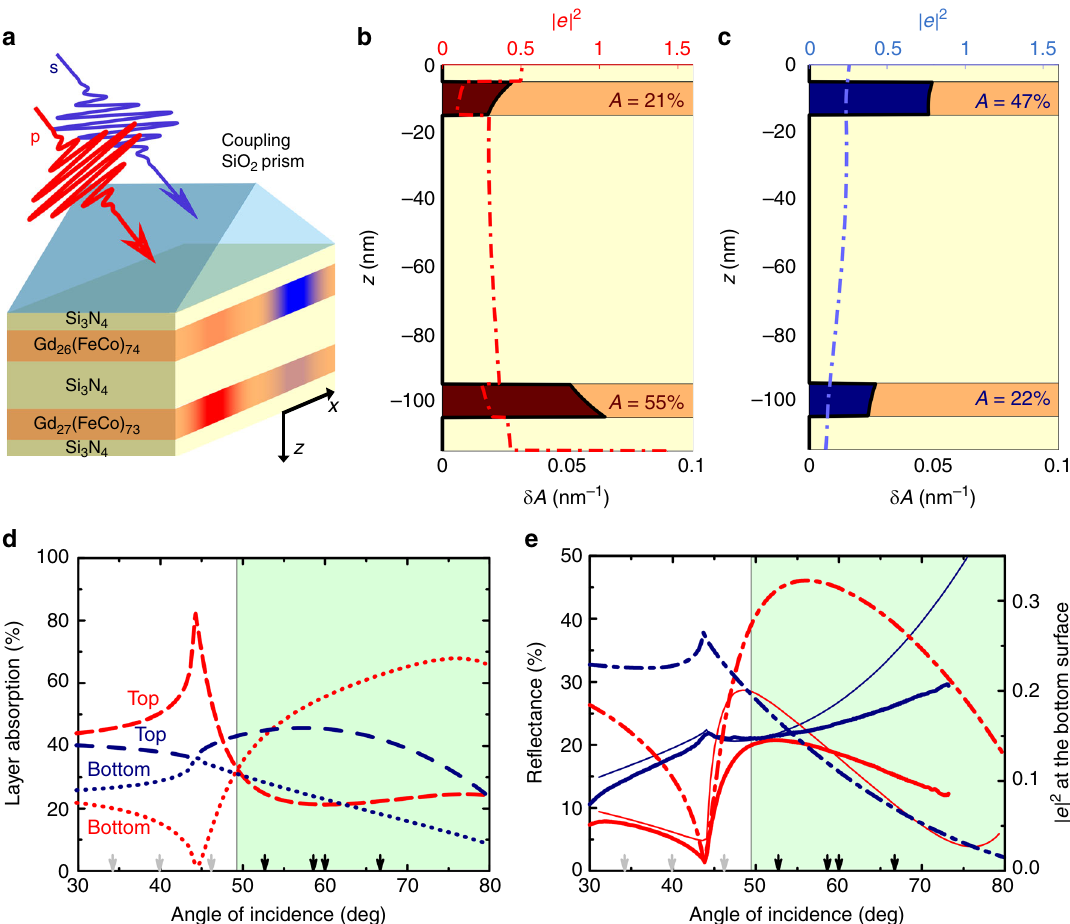
Fig. 1 The scheme of polarization-based layer-resolved all-optical toggling of magnetization. a Physical scheme and sample design. The p-polarized/s- polarized optical pulse (and the associated targeted layer for magnetization reversal) is shown by red/blue. b , c The distribution of | e | 2 (dashed-dotted line) and the partial δ A and total A absorption (solid line) inside the multi-layered heterostructure for p-polarized and s-polarized optical pulses respectively, with fi xed wavelength 800 nm and angle of incidence 59°. d Calculated angular dependence of the absorbed optical energy by the top (dashed line)/ bottom (dotted line) layer with incident p-polarized (red)/s-polarized (blue) light. e Calculated (thin solid lines) and experimentally measured (thick solid lines) re fl ectance angular spectra for incident p-polarized (red)/s-polarized (blue) light. Also shown is the calculated strength of | e | 2 at the bottom surface of the bottom Gd 27 (FeCo) 73 layer with incident p-polarized (red dashed-dotted line)/s-polarized (blue dashed-dotted line) light. In panels d-e, the green background colour indicates the predicted region where the absorption of p-polarized light in the bottom Gd 27 (FeCo) 73 layers is greater than in the top Gd 26 (FeCo) 74 layer. This is the region with expected polarization-controlled layer selective switching of magnetization. The black and grey arrows indicate the angles where the polarization-based all-optical switching experimentally succeeded and